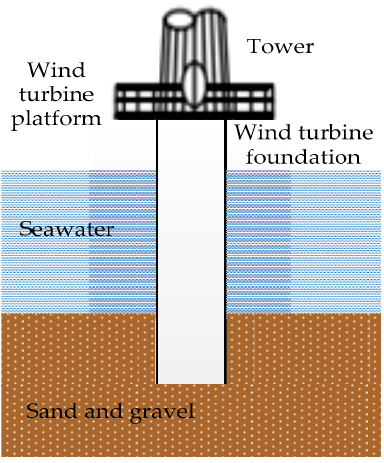
Figure 1. Single foundation schematic.